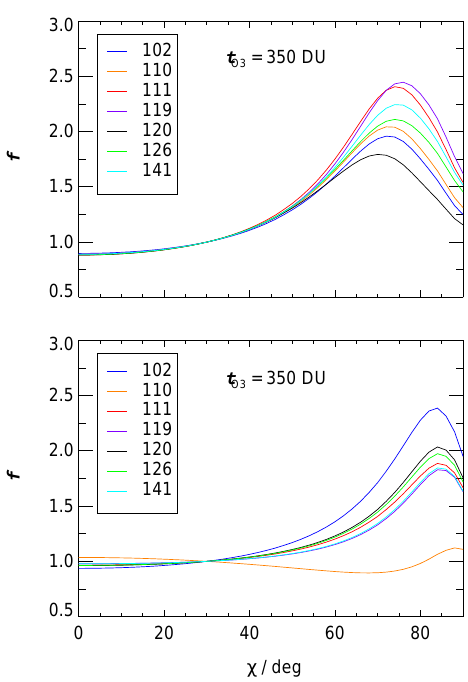
) according to Eq. (5) for all Figure 5. Correction factors f (χ,t O 3 FR instruments as a function of solar zenith angle at a fixed total ozone column of 350DU. Upper and lower panels show correction factors for old and new interference filters,